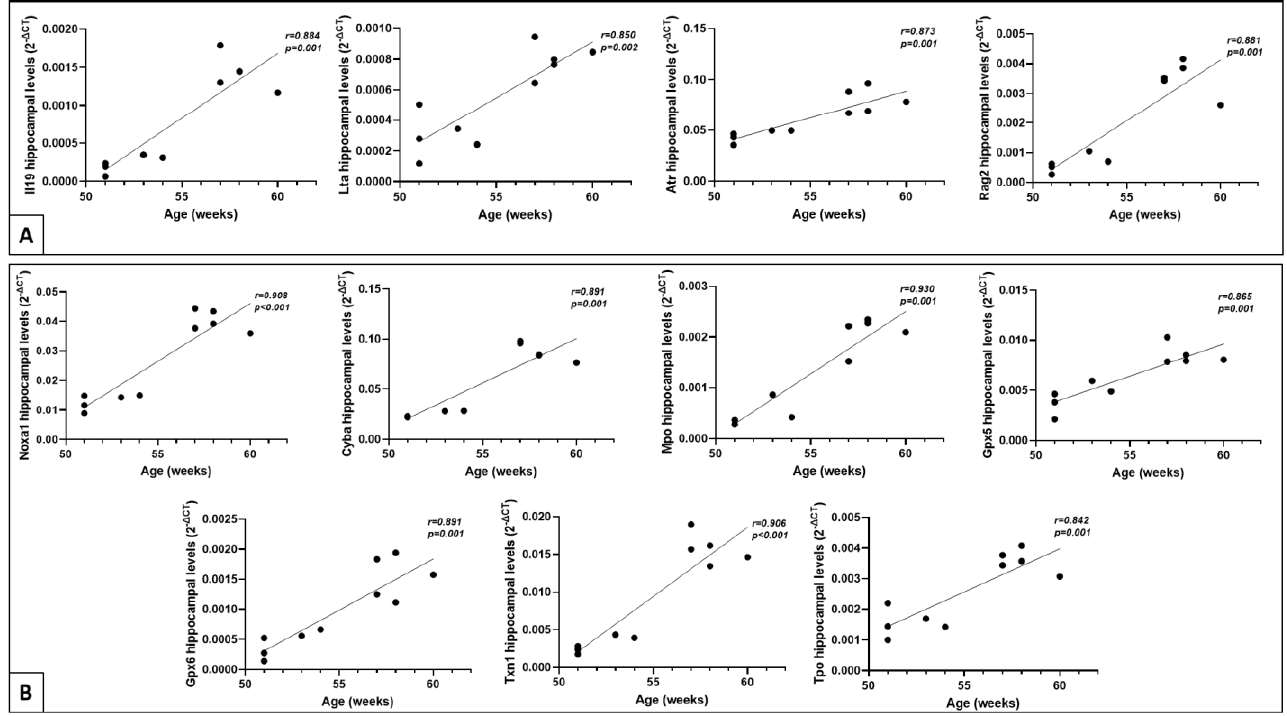
Figure 5. Correlations between the mRNA hippocampal levels of ( A ) inflammation and ( B ) redox genes with the age (in weeks) of AT mice (N = 10). Genes with |FR| > 1.8 and p < 0.05 were analyzed. The gene expression levels are presented as 2 −∆CT values.